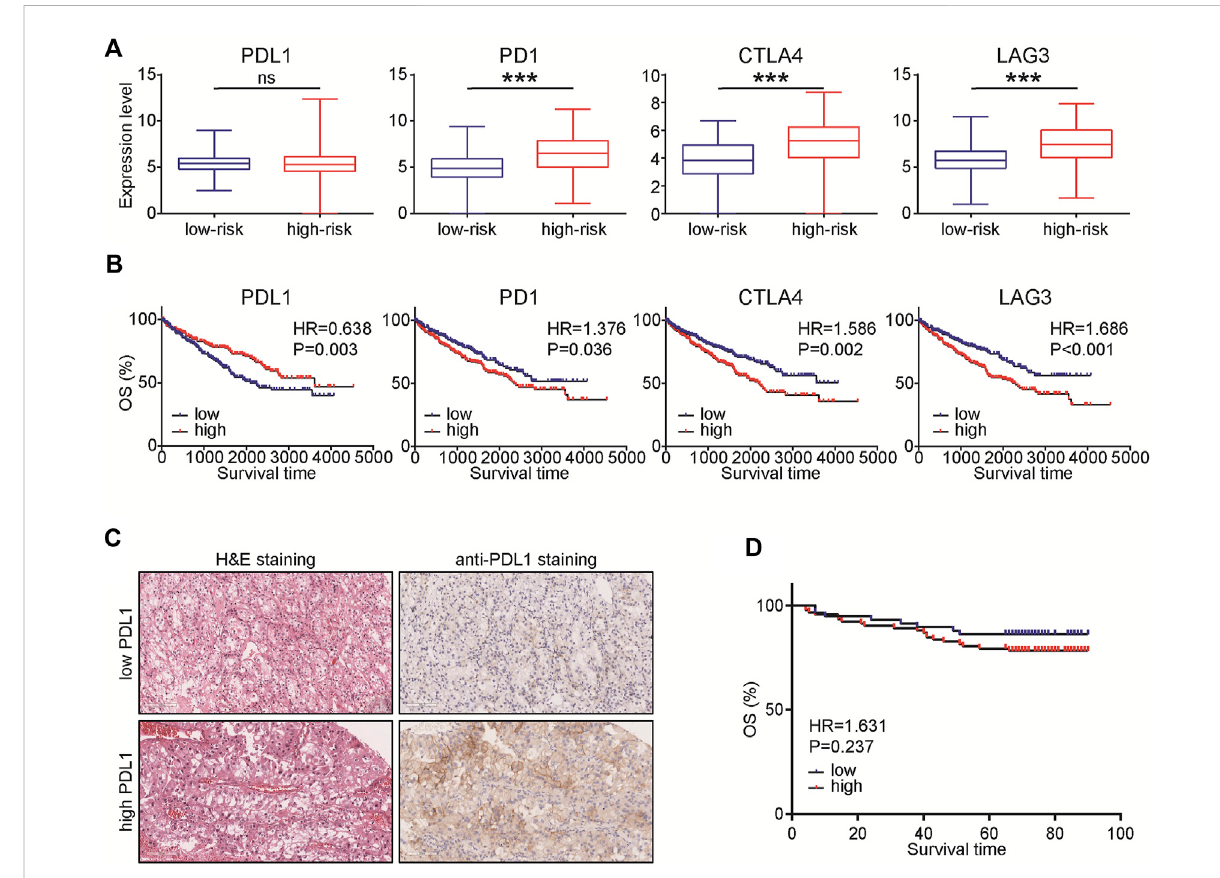
FIGURE 7 Expression levels of immunosuppressive molecules in various groups. (A) Expression levels of PDL1, PD1, CTLA4, and LAG3 in ccRCC with low- and high-risk. Signi fi cance was calculated with Student ’ s t-test. *** p < 0.001. (B) Prognostic values of PDL1, PD1, CTLA4, and LAG3 in ccRCC. Signi fi cance was calculated with log-rank analysis. (C) Representative images revealing PDL1 expressionin ccRCC samples using anti-PDL1 staining. Magni fi cation, × 200. (D) Prognostic values of PDL1 in 150 ccRCC patients. Signi fi cance was calculated with log-rank